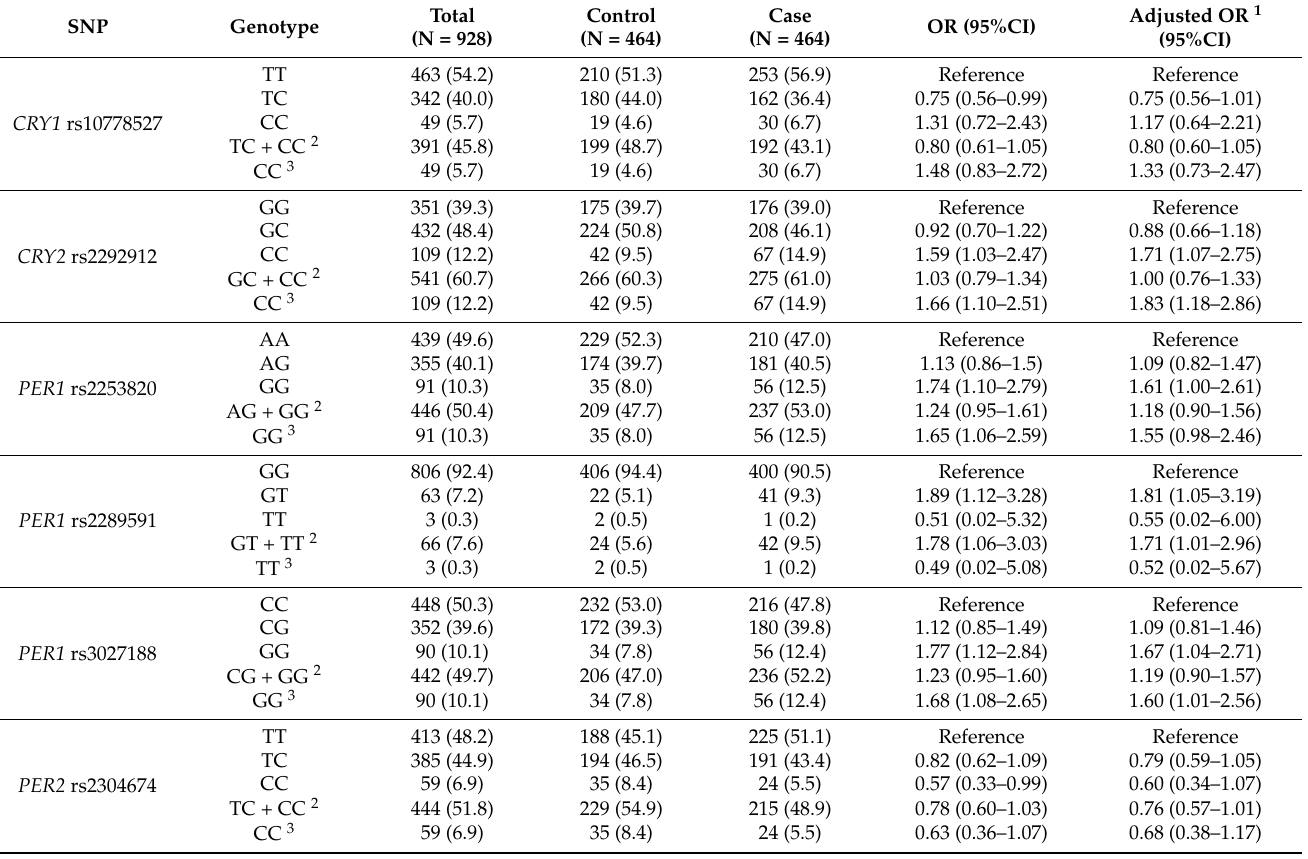
Table 3. Association between SNPs of circadian genes with breast cancer risk in univariate and multivariate logistic regression